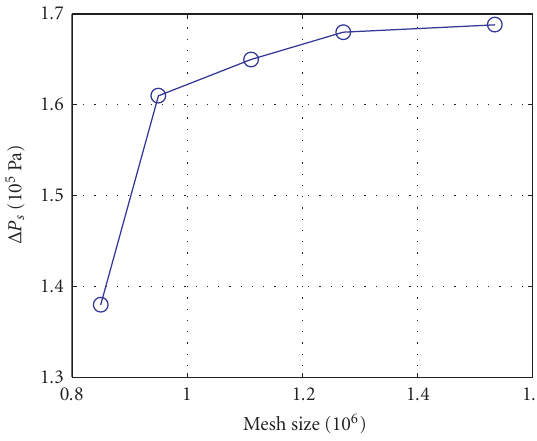
Figure 5: Influence of the grid size on the solution—nonsplittered pump at